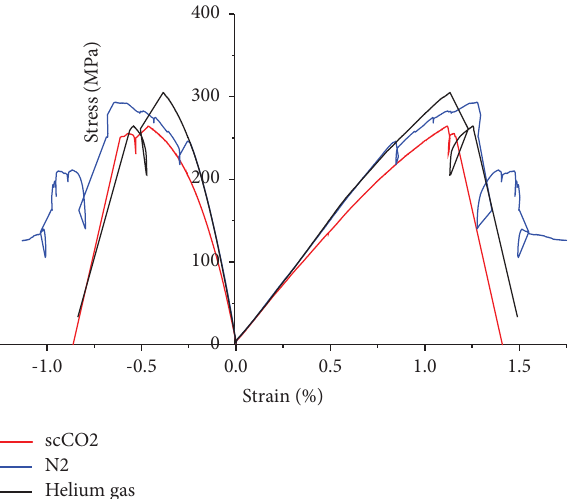
Figure 10: Stress-strain curves at the coring angle of 90 ° .